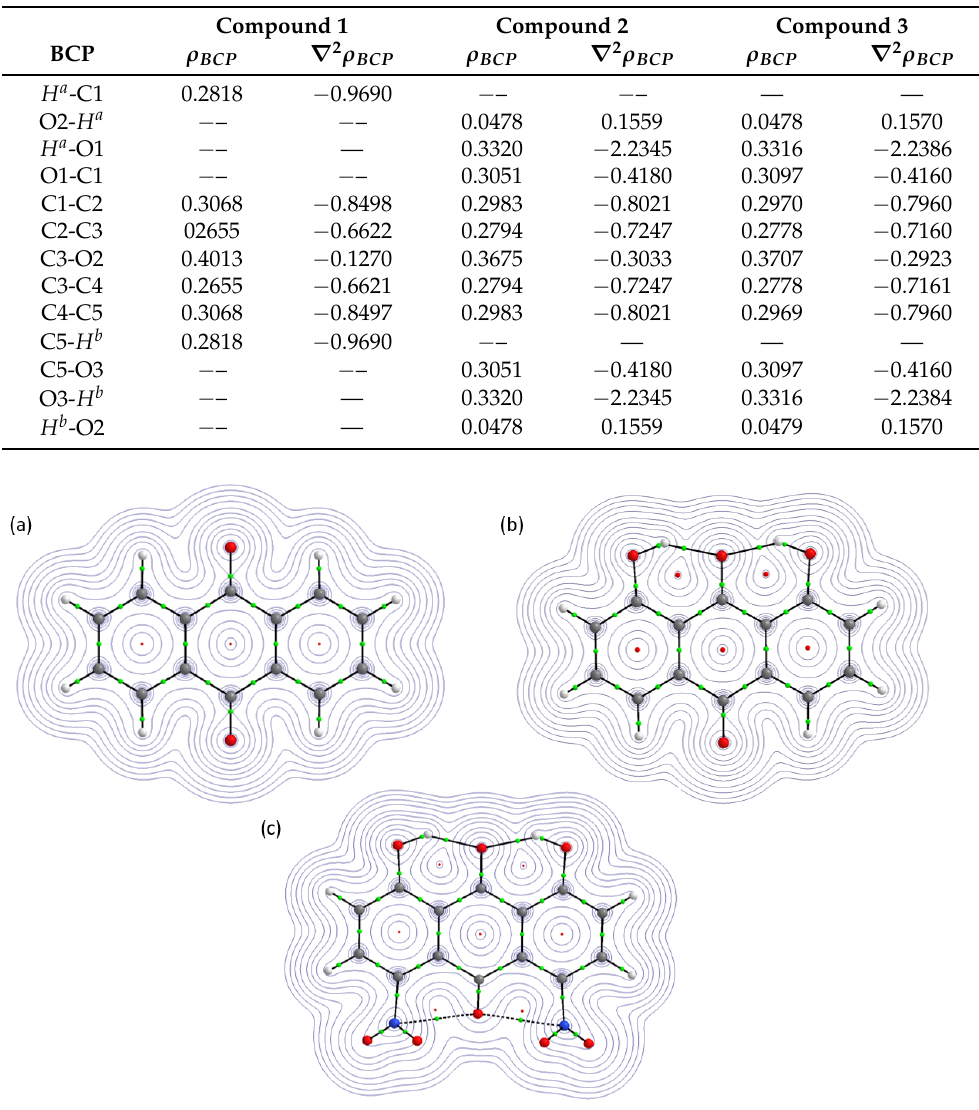
Figure 4. Electron density contour maps of the investigated molecules: ( a ) Compound 1 , ( b ) Com- pound 2 , ( c ) Compound 3 . Small green spheres denote Bond Critical Points, while small red spheres denote Ring Critical